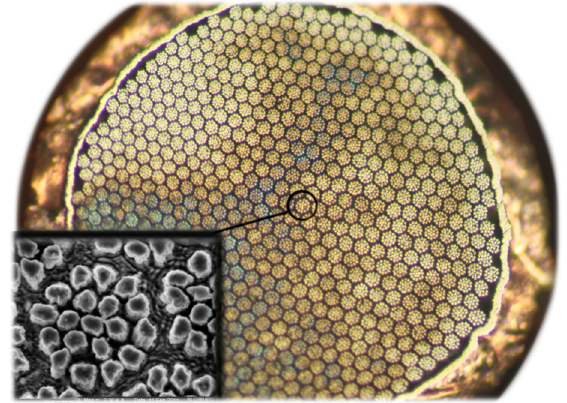
FIG. 4. A close-up view to a typical bronze route strand used in our measurements. The wire has 14326 filaments grouped in 754 bunches of 19 filaments each, 6 : 6 (cid:2) m in diameter sur- rounded by a Ta barrier and a Cu stabilizer sheath. A SEM picture of the structure is show on the bottom left. The full diameter of the multifilamentary cathode is 0.8